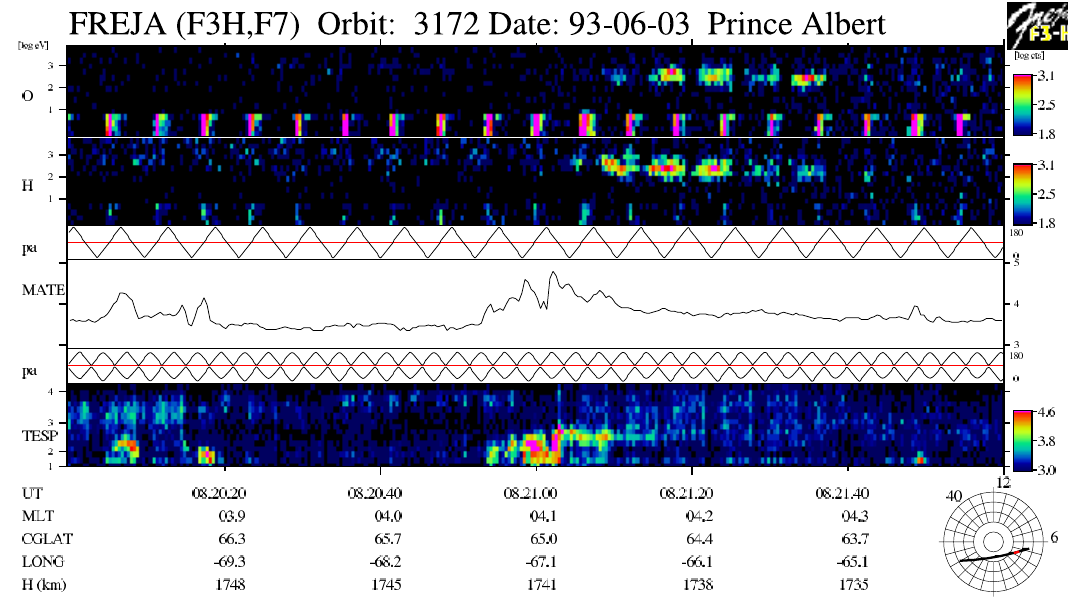
Fig. 2. A CSP of the higher time resolution type, covering 2min of time. It shows the period of orbit 3172 in Fig. 1 when precipitating ions were recorded. This higher time resolution CSP differs from the low time resolution kind shown in Fig. 1 only in that frames 3 and 5 contain pitch-angle data instead of auxiliary